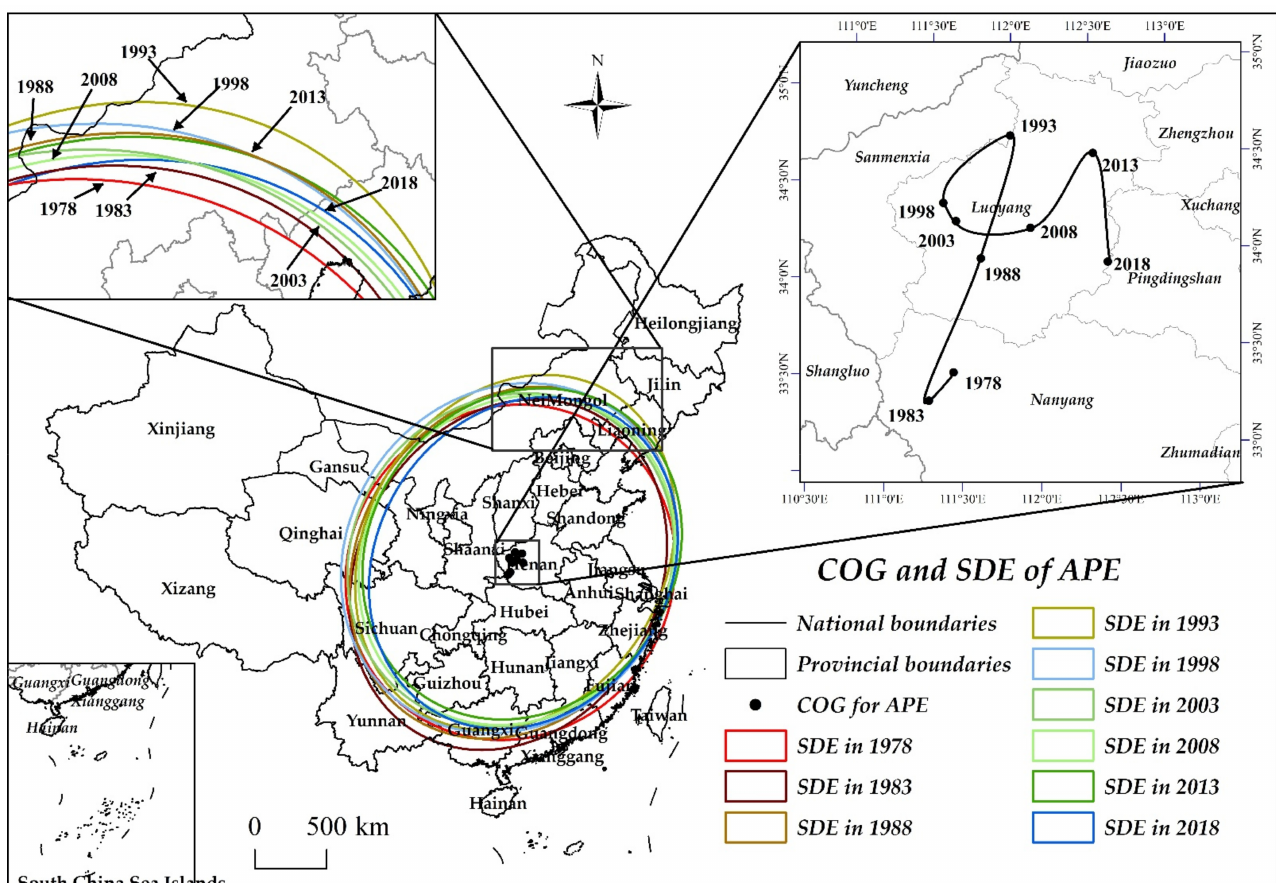
Figure 3. Changes of the COG and SDE of APE in China since